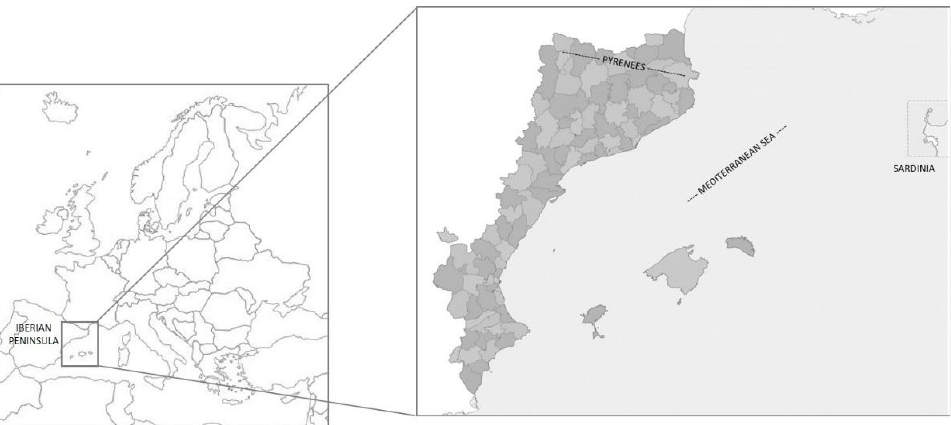
Figure 2. Map of Catalan linguistic area within Europe.